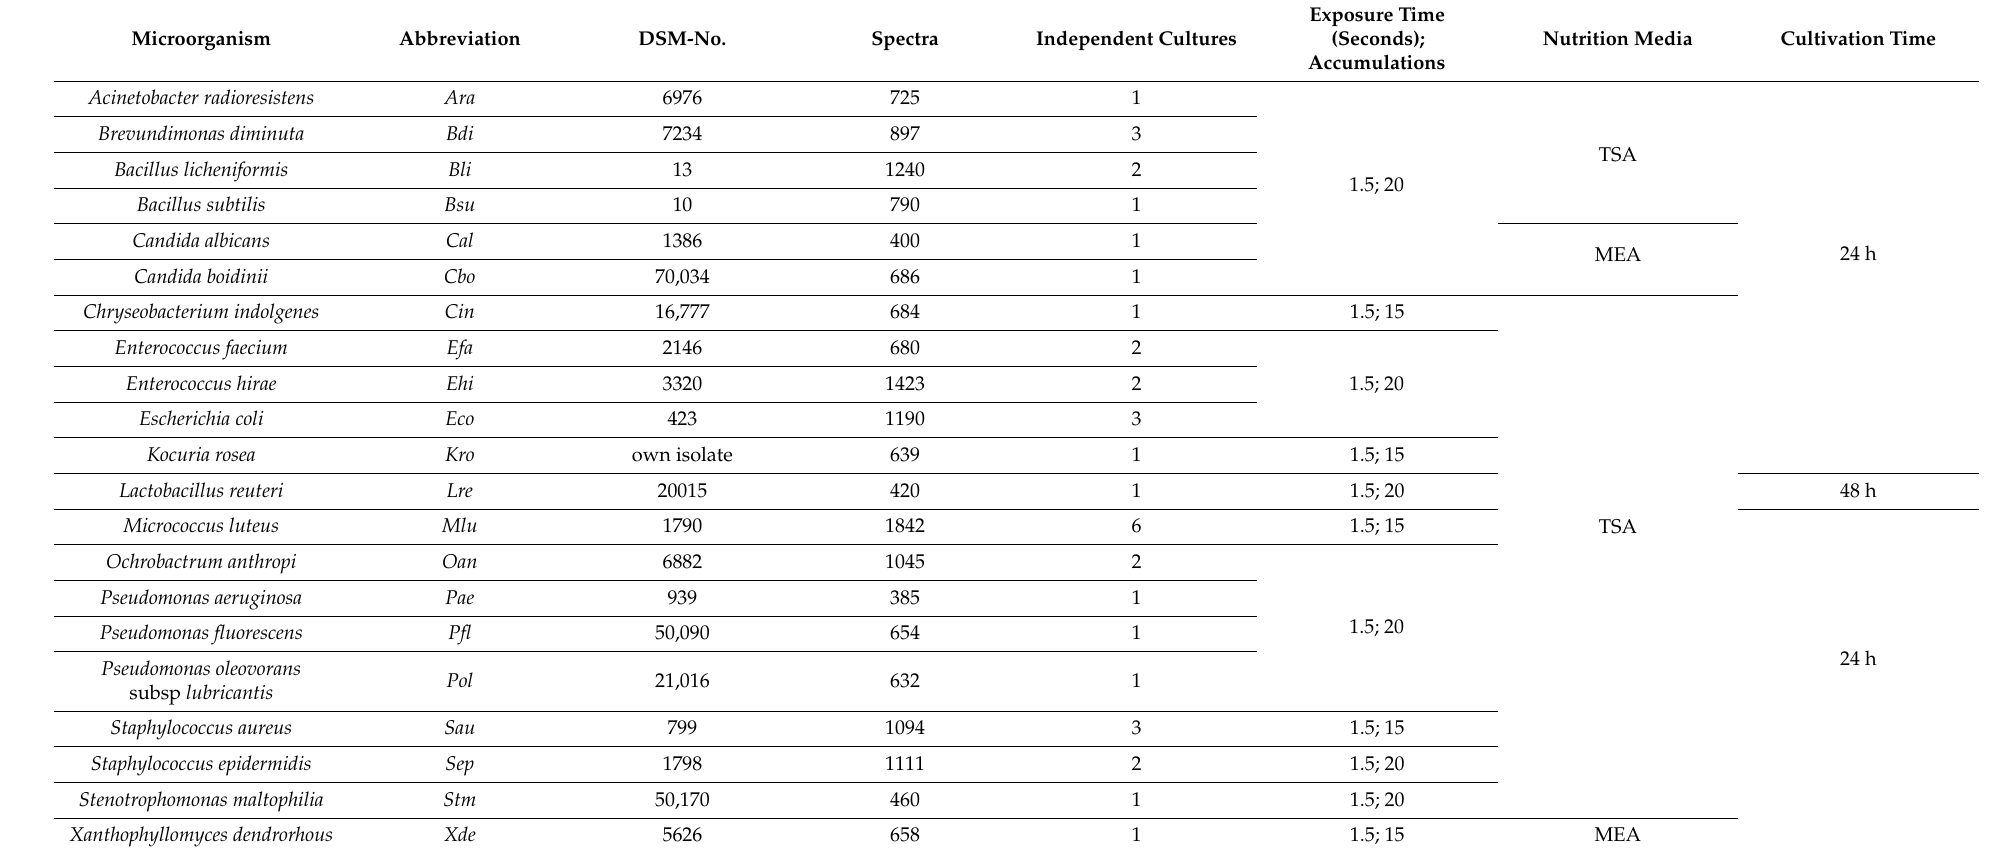
Table 1. List of species included in the database with their DSM-No. and additional information on the number of spectra, number of independently grown cultures, used exposure time, accumulations per spectrum, and growth conditions; all spectra have been recorded with an excitation wavelength of 633 nm at about 3.5 mW laser power on